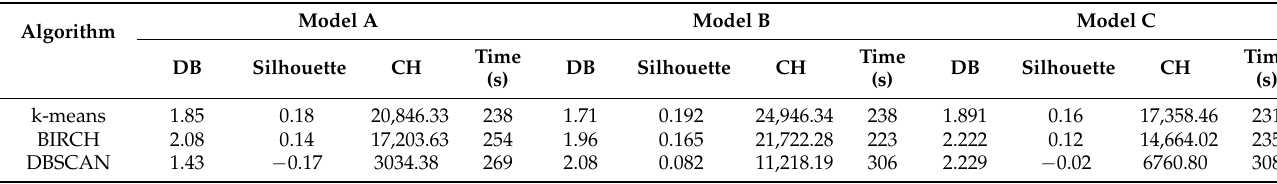
Table 8. Result of clustering model